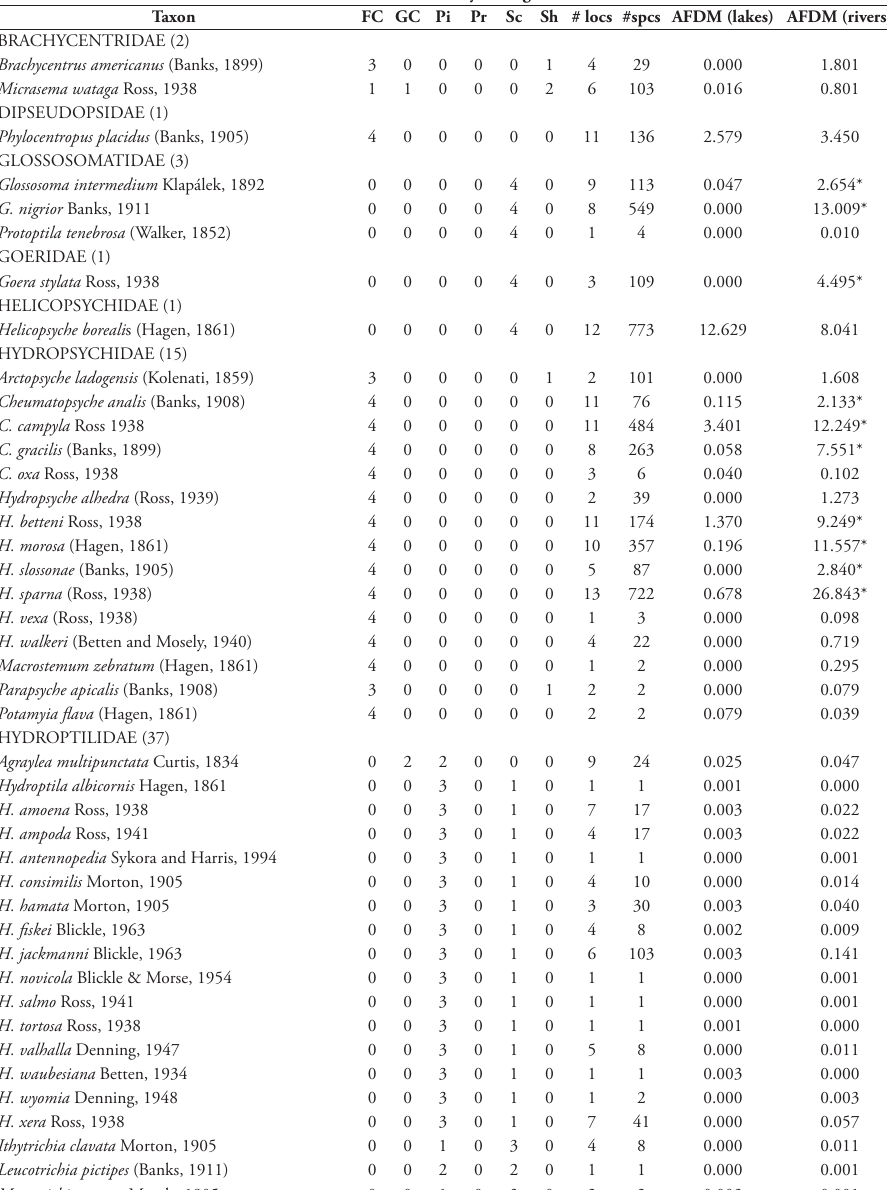
Table 3. The 169 caddisfly species collected during this study, showing total number of localities (#locs) and total number of specimens (#spcs), and mean ash-free dry mass (AFDM) (mg) from lakes and rivers. Species are organized alphabetically by family and genus. Asterisks denote significant affinity with lakes or rivers based on indicator species analysis. Functional feeding groups (FFGs) as follows: FC = filtering collector, GC = gathering collector, Pi = algal piercer, Pr = predator, Sc = scraper, Sh =